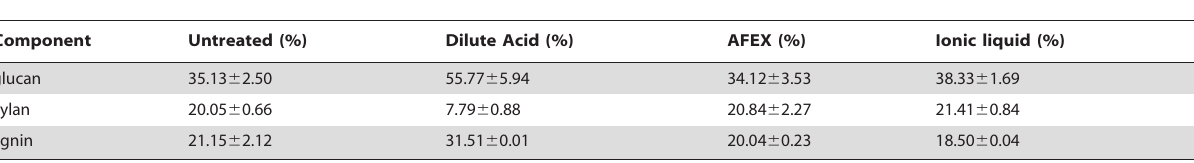
Table 1 . Compositional analysis of untreated and pretreated switchgrass.